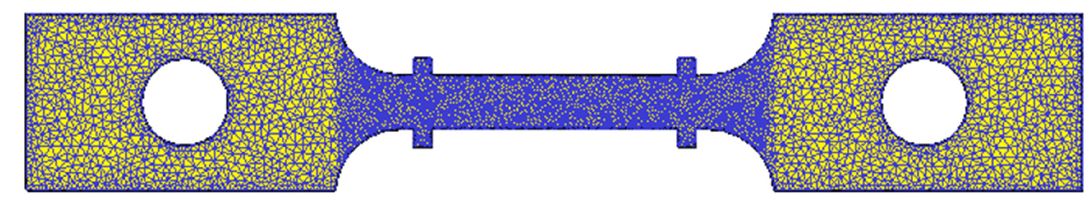
Figure 6. Finite element model of the tensile test.